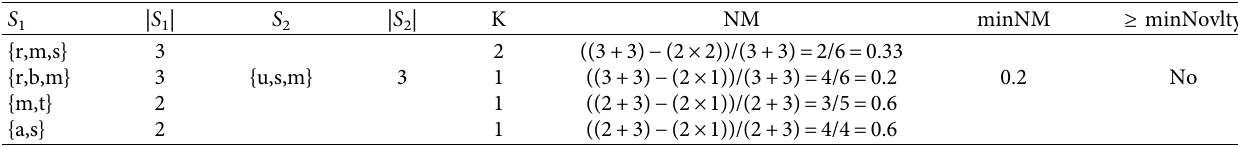
Table 4: NM calculation between the new MFIs {u,s,m} and all IMFIs in IMFI